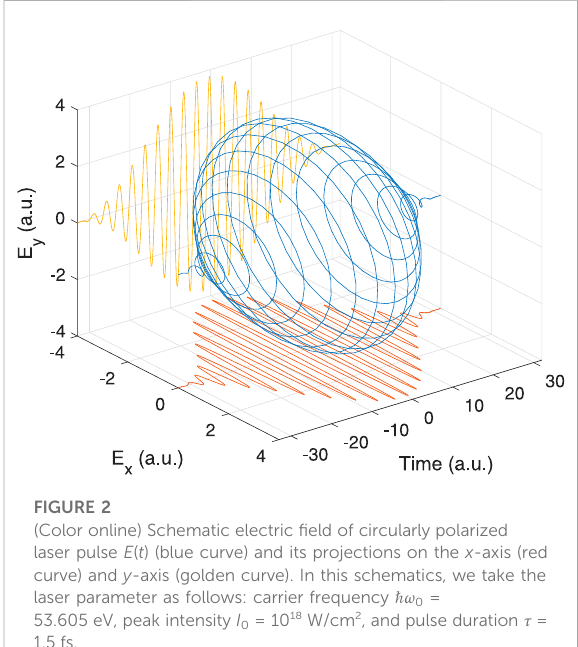
FIGURE 2 (Color online) Schematic electric fi eld of circularly polarized laser pulse E ( t ) (blue curve) and its projections on the x -axis (red curve) and y -axis (golden curve). In this schematics, we take the laser parameter as follows: carrier frequency Z ω 0 = 53.605 eV, peak intensity I 0 = 10 18 W/cm 2 , and pulse duration τ = 1.5 fs.